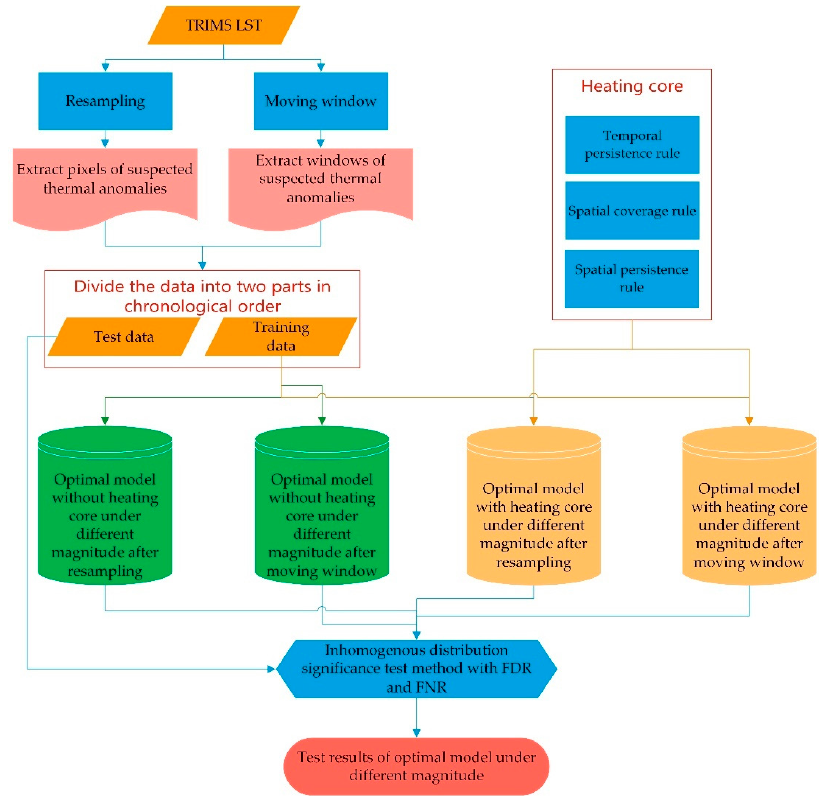
Figure 3. Experimental flowchart of this research.